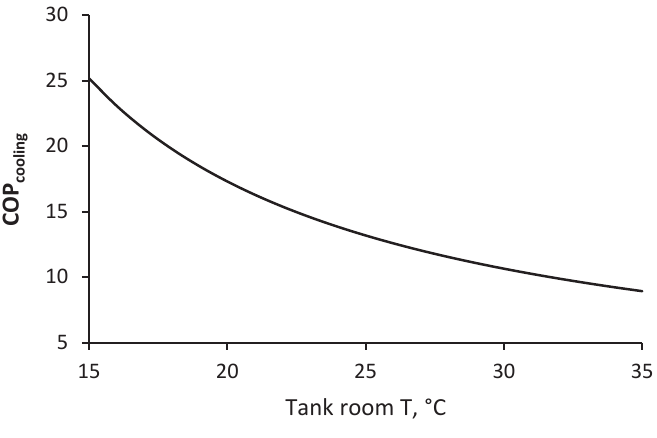
Fig. 5. Theoretical maximum COP (COP respect to the tank room temperature, at the end of the cooling